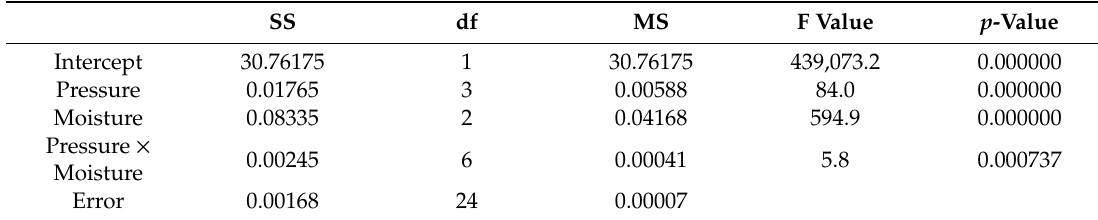
Table 2. Two-way analysis of variance (ANOVA)—DE.